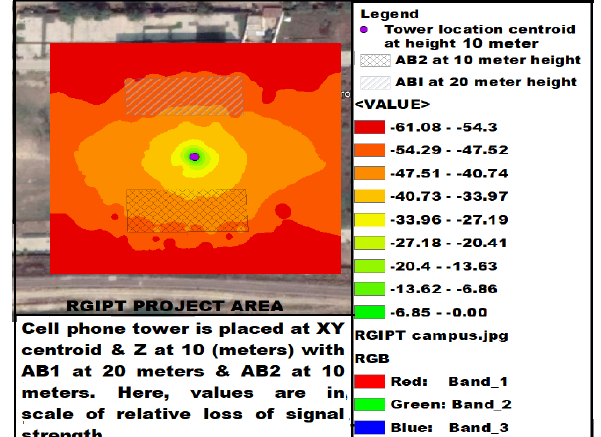
Figure 22. Cell phone tower at XY Centroid and Z at 10 meters when both building heights are different.